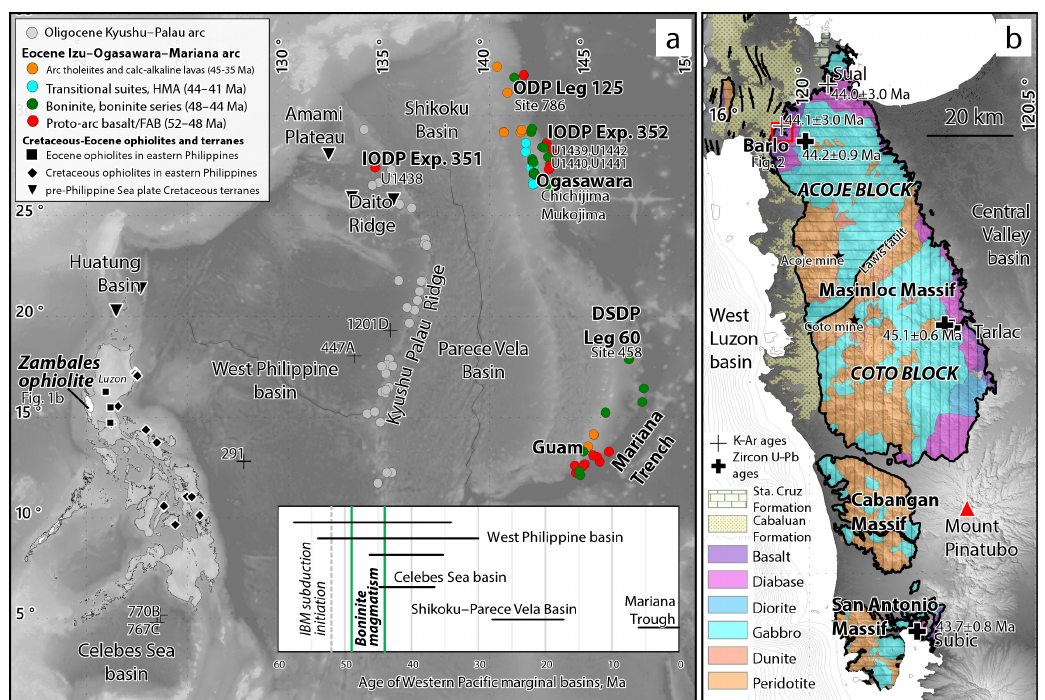
Figure 1. (a) Distribution of subduction initiation rock suites in the Philippine Sea plate and spreading histories of associated marginal basins (Deschamps and Lallemand, 2002; Pearce et al., 1992; Reagan et al., 2017). (b) Regional geological map of the Zambales ophiolite after Yumul et al. (1990) with whole-rock K–Ar and zircon U–Pb ages from Fuller et al. (1989) and Encarnacion et al. (1993). The 44–43Ma Acoje Block consists of the northern Masinloc Massif and the southernmost San Antonio Massif. The enclosed region (red box) is the Barlo extrusive section mapped in this